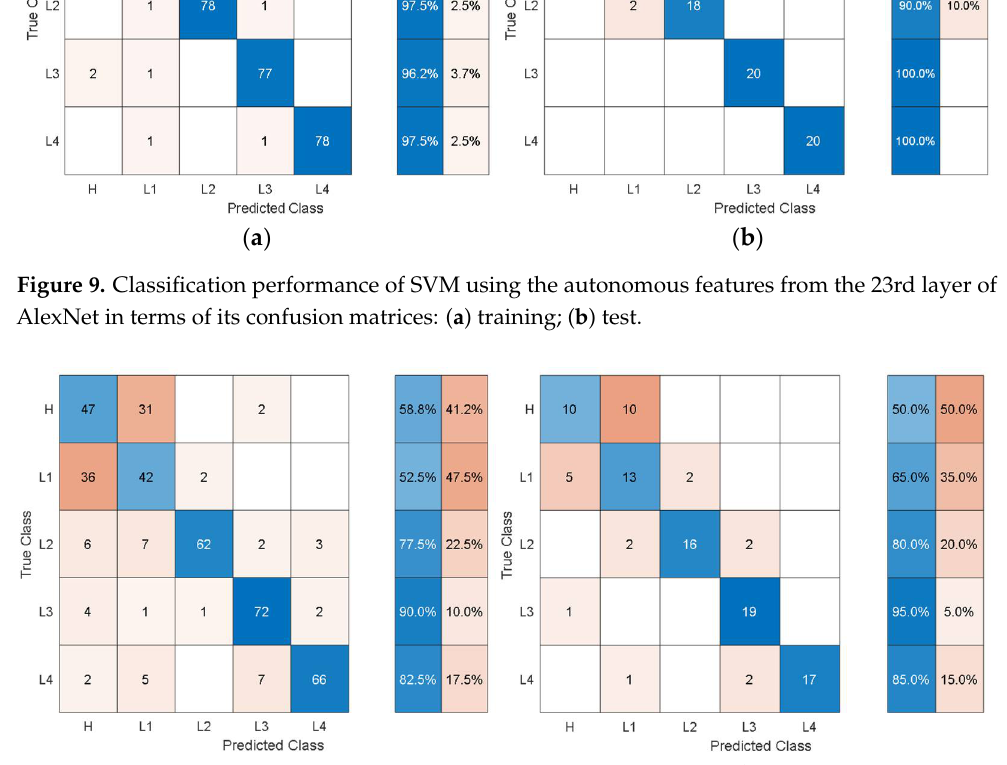
Figure 9. Classification performance of SVM using the autonomous features from the 23rd layer of AlexNet in terms of its confusion matrices: ( a ) training; ( b ) test.